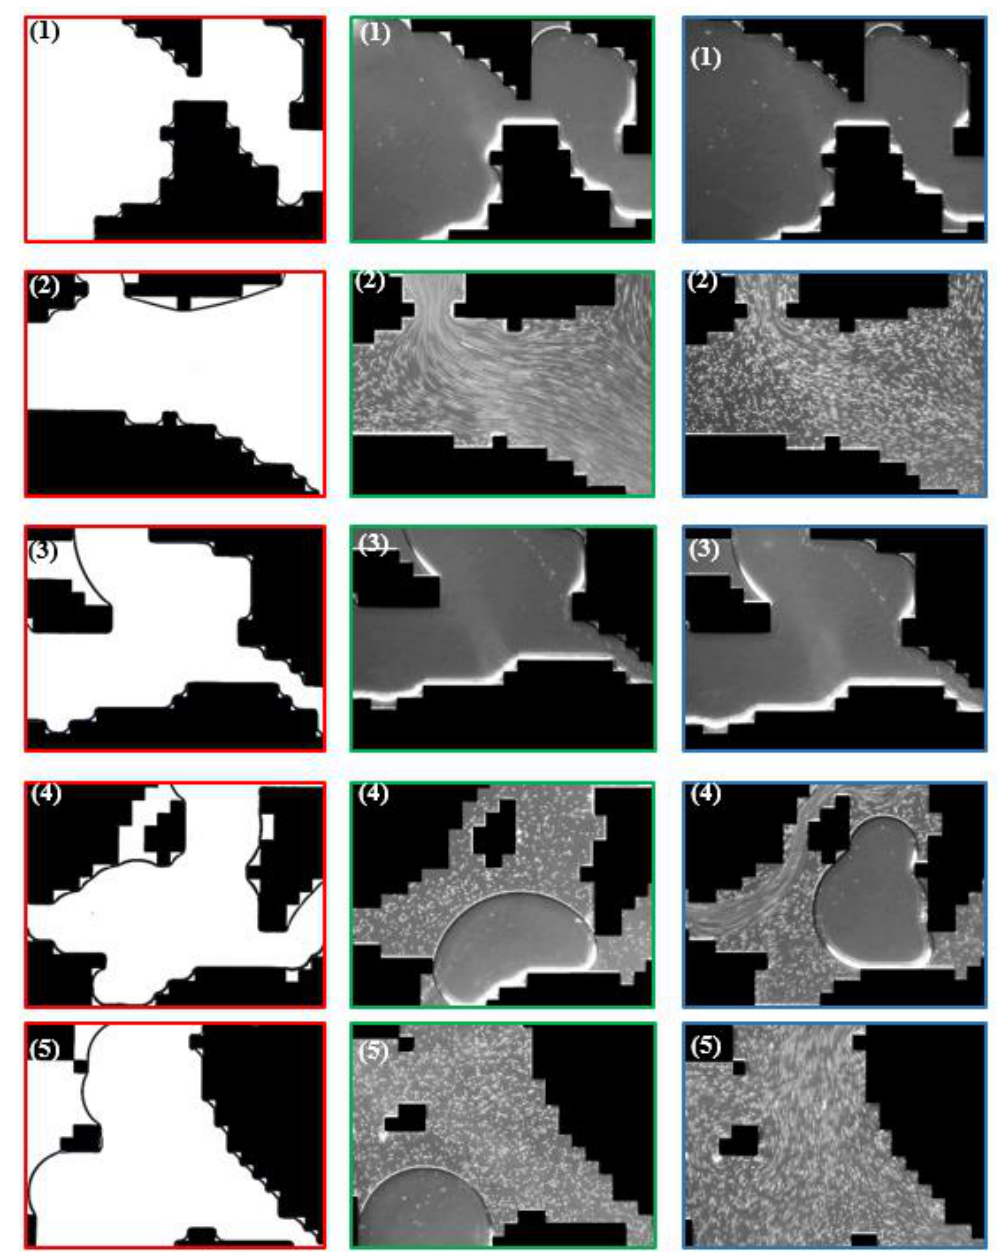
Figure 21. (Red) Binary images of the initial oil saturation in the selected pores. The images refer to the evaluation and analysis of a 500 ppm polymer solution at laminar flow conditions; (green) Streamline visualization during polyethylene oxide (PEO) flooding in the selected pores. The images refer to the evaluation and analysis of PEO (3350 ppm) at laminar flow conditions using an injection rate of 0.5 µL/min; (blue) Streamline visualization during 500 ppm polymer flooding in the selected pores. The images refer to the evaluation and analysis of the 500 ppm polymer solution at laminar flow conditions using an injection rate of 0.5 µL/min [11]. The initial oil saturations ( S oi ) for pores 1 to 5 were 97.94%, 95.21%, 90.07%, 86.18% and 84.30%. After S oi was determined, non-viscoelastic polyethylene oxide (PEO) were injected (0.5 µL/min) in order to displace the oil without any viscoelastic effects. The residual oil saturations ( S or ) after PEO flooding from pores 1 to 5 were 97.94%, 0.00%, 90.07%, 34.64% and 20.18% respectively.